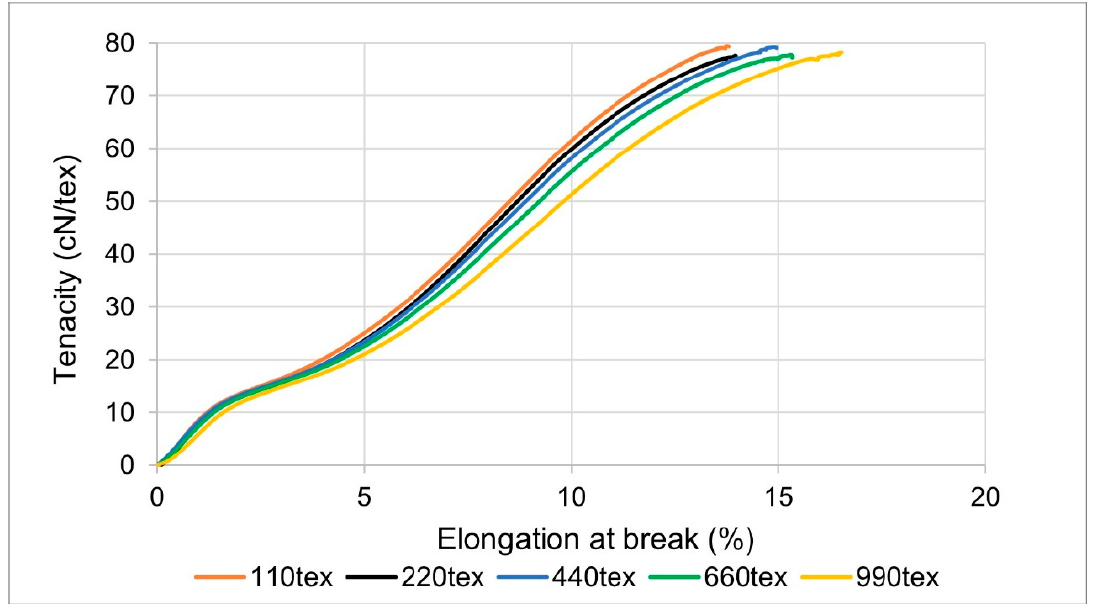
Figure 3. Stress–strain diagram of unaged high tenacity polyester